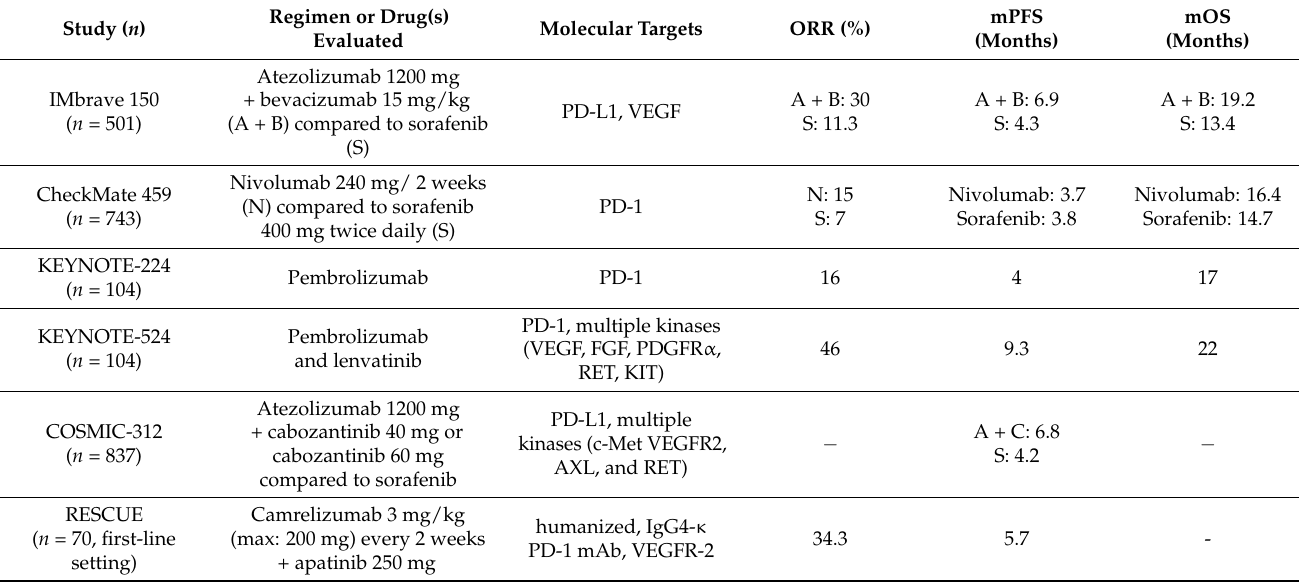
Table 4. Key clinical trials involving immunotherapy agents in first line setting in hepatocel- lular